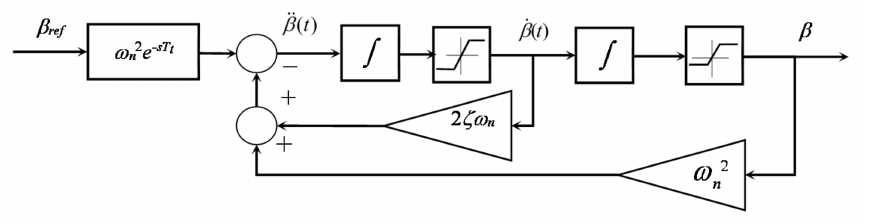
Figure 19. Pitch actuator model based on a second order system with dead time.